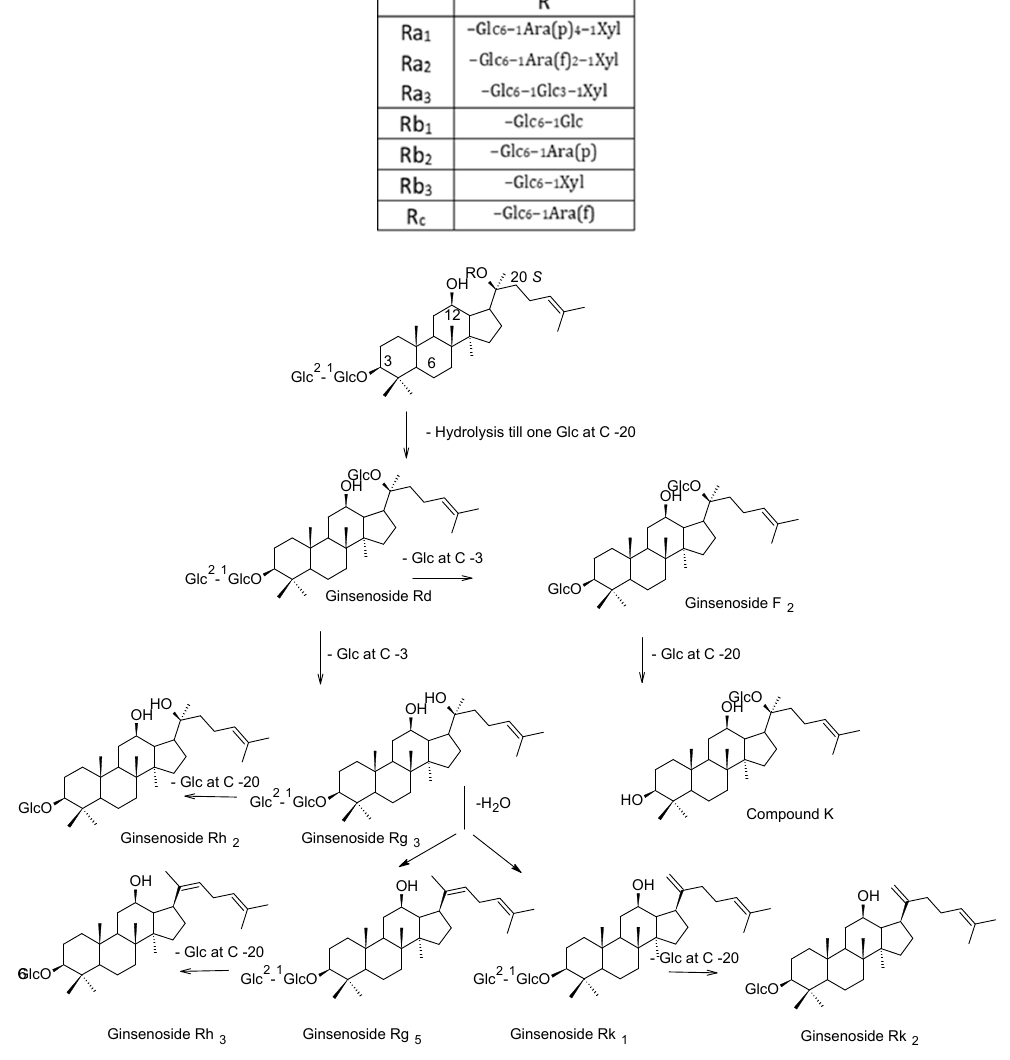
Figure 2. Pathways of chemical changes of protopanaxadiol (PPD)-type ginsenosides during black ginseng processing.